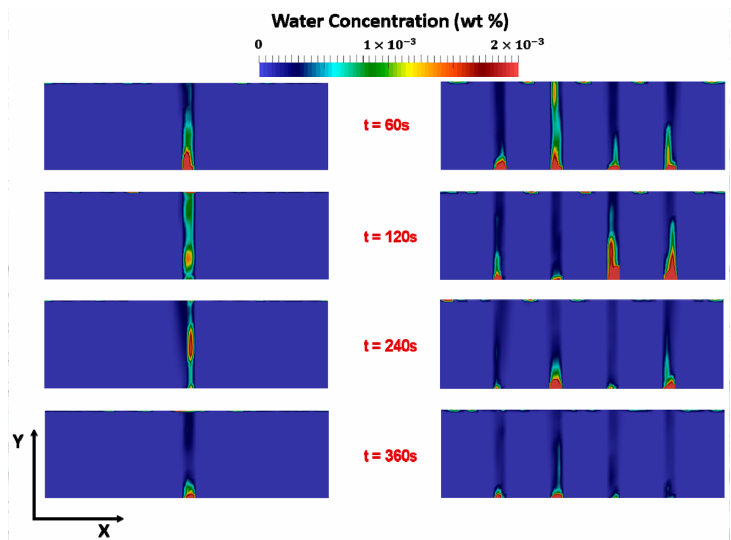
Figure 4. The water vapour absorbed by the rising NEA in slices of the fuel (ullage is excluded) in the xy plane at the center of the tank, for a single-inlet ( left ) and four-inlets ( right ). Four different times are shown. The total mass flow in the two systems is the same ( ≈ 3.95 × 10 − 4 kg/s). Note that the figure shows only the water that has vapourized into the NEA/air. Since the concentration of NEA in the fuel away from the columns is approximately zero, the concentration of water vapour is also